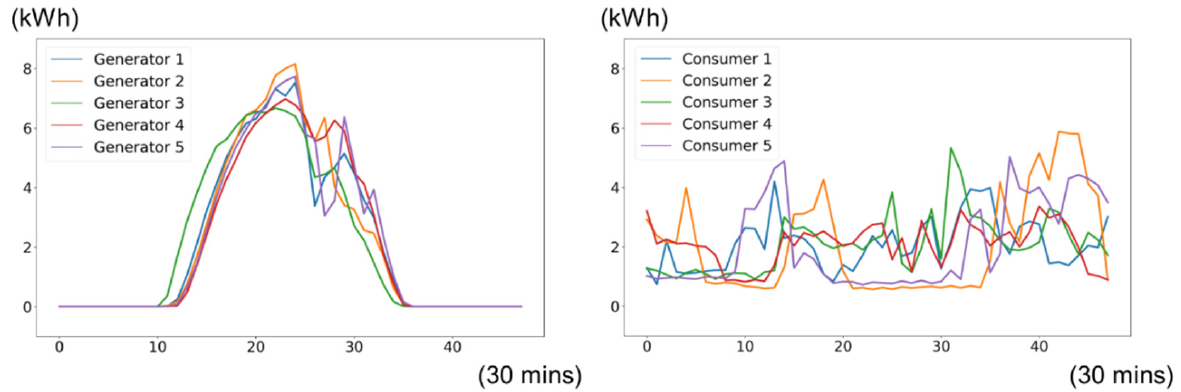
Figure 11. PV generations ( left ) and power consumptions ( right ) of five households were converted to 30-min values and adjusted to a total of 100 kWh.